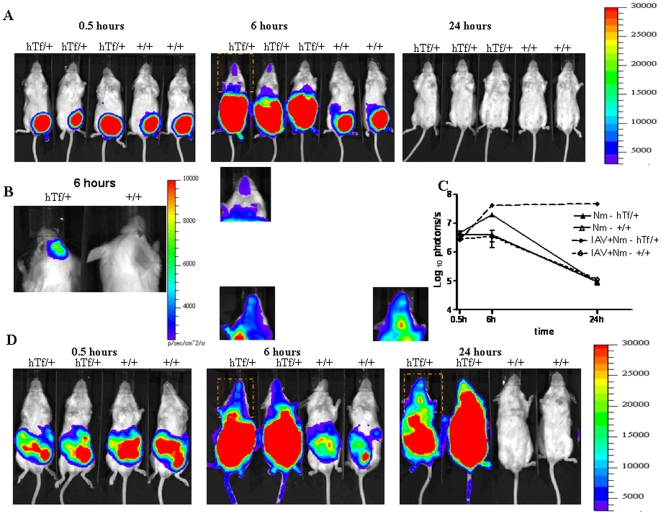
Dissemination of N. meningitidis in BALB/c congenic mice that were infected by intraperitoneal injection of 5*106 CFU of N. meningitidis (Nm) strain NM0804 expressing the luciferase.Mice were then analyzed for bioluminescence at the indicated times. Images depict photographs overlaid with colour representations of luminescence intensity, measured in photons/second and indicated on the scales, where red is most intense and blue is least intense. (Top row) (A) Ventral views of a three transgenic mice expressing human transferrin (hTf/+) and two wild type mice (+/+) at the indicated times. The framed region of the first transgenic mice is shown below for more details of the bioluminescence imaging in the skull. (B) Dorsal view of the skull of one transgenic mouse expressing human transferrin and one wild type mouse. The substrate of firefly luciferase was injected directly into the lateral ventricle after 6 h of bacterial intraperitoneal challenge. (C) The luminescence of the hTf/+ and (+/+) mice from A and D was quantified and expressed as means ± SD from each category at the indicated times by defining specific representative region of interest encompassing the entire animal.(D) Ventral views of a three transgenic mice expressing human transferrin (hTf/+) and two wild type mice (+/+) at the indicated times. Mice were first infected by influenza A virus (IAV) by intranasal inhalation. Mice were then infected after 7 days by N. meningitidis (Nm) strain NM0804 by intraperitoneal injection. The framed region of the first transgenic mice is shown below for more details of the bioluminescence imaging in the skull.